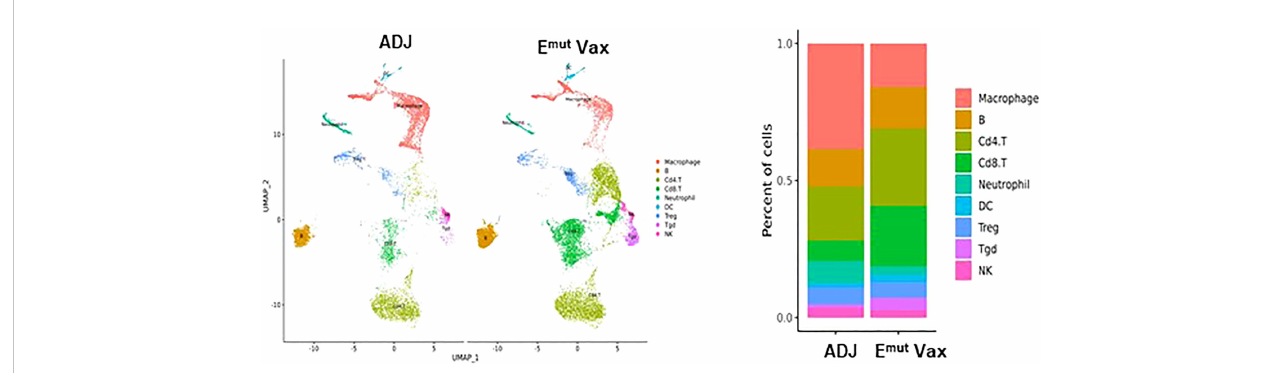
FIGURE 5 Clustering analysis of scRNA-seq data from tumor-in fi ltrating cells in adjuvant controls and E mut Vax treated mice. Left panel: The overall immune landscape across adjuvant control and E mut Vax treatment groups. Right panel: The percentage changes of each immune cell population between the adjuvant control and E mut Vax treatment groups. E mut Vax versus ADJ group cell percentage comparison: Macrophage: P = 0.008; B cells: P = 0.09; Cd4 + T cells: P = 0.02; Cd8+ T cells: P = 0.03; Neutrophil: P = 0.05; DC: P = 0.043; Treg: P = 0.11; Tgd: P = 0.052; NK: P =